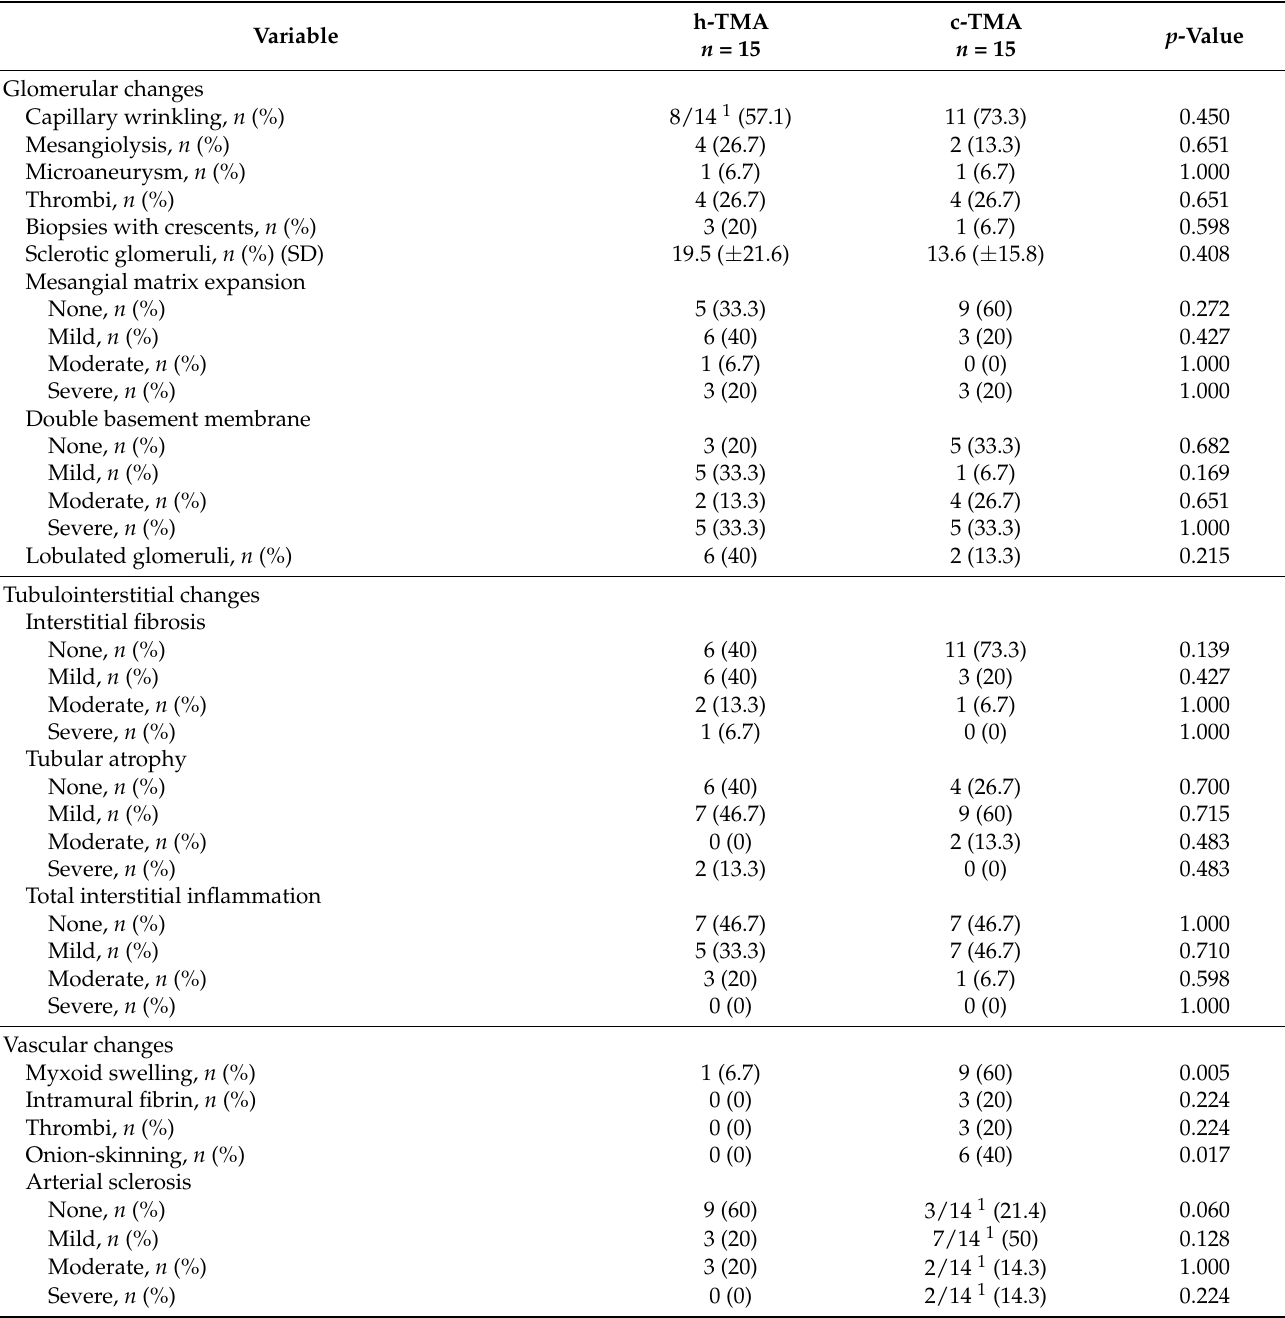
Table 5. Histological variables of TMA patients. Values are expressed as means ( ± SD), or number of patients (percentages). p -value shows the comparison between histological TMA (h-TMA) and clinical TMA (c-TMA)